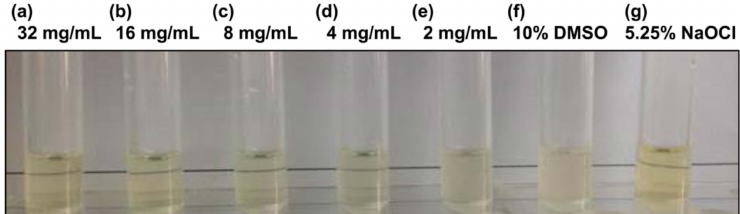
Figure 1. The minimum inhibitory concentration of chlorogenic acid against Porphyromonas gingivalis . The visualizing turbidity measurement method was used to determine the MIC. The test samples contained ( a ) 32 mg / mL, ( b ) 16 mg / mL, ( c ) 8 mg / mL, ( d ) 4 mg / L, and ( e ) 2 mg / mL chlorogenic acid dissolved in 10% dimethyl sulfoxide (DMSO). ( f ) 10% DMSO and ( g ) 5.25% sodium hypochlorite represented the negative and positive control groups,